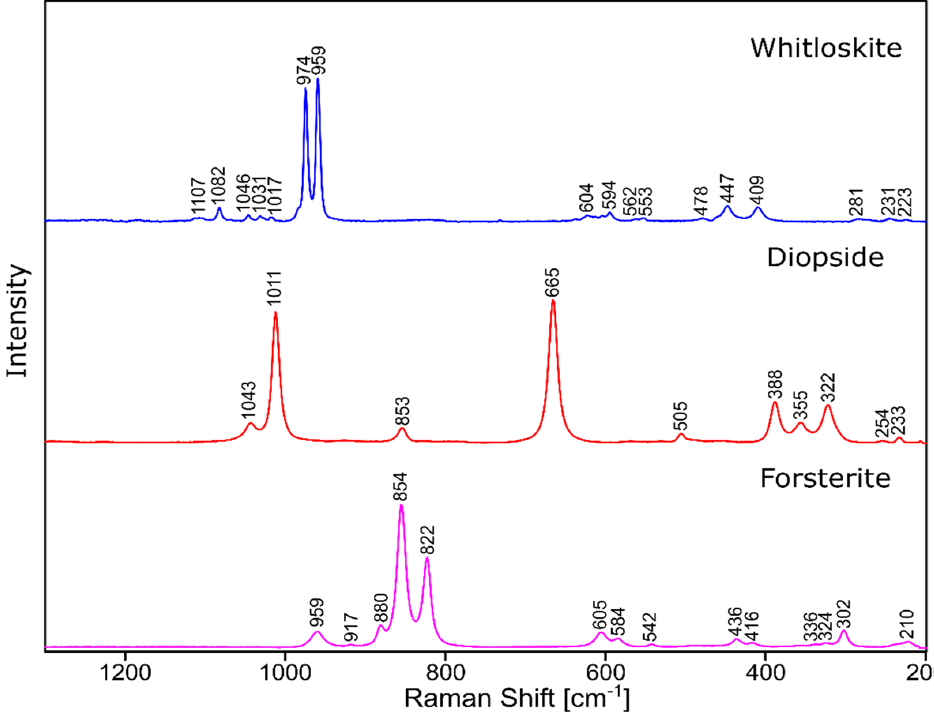
Figure 11. Raman spectra of standard substances.